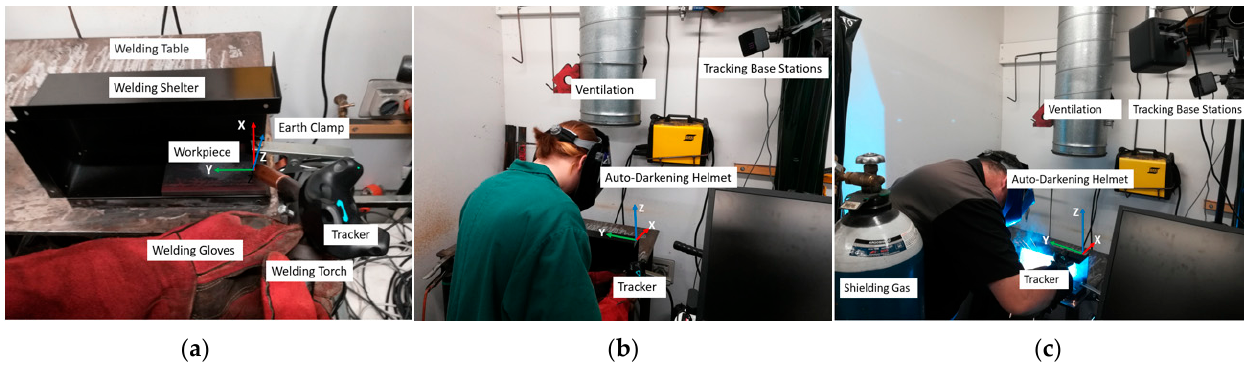
Figure 1. The hardware components of the GMAW motion tracking platform. ( a ) Welding motion-tracking platform, including welding shelter, welding torch, and the attached motion tracker; ( b ) an unskilled welder performing manual welding for motion data collection and analysis; ( c ) a professional welder performing on-site GMAW operation for expertise and skill extraction.